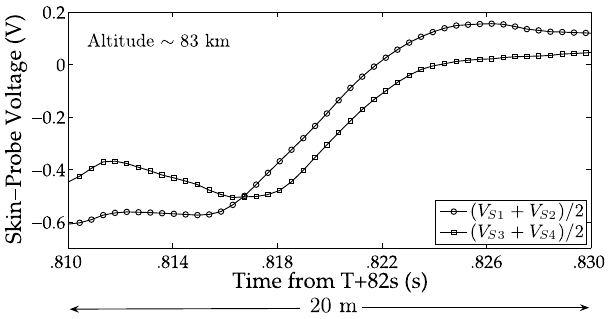
Fig. 5. A high time-resolution view of the onset of the NLC layer in Fig. 4b. The transition takes less than 10ms, over much of which the potential varies linearly with time/altitude. There is a delay between the forward and aft channels of about 2.5ms, which is roughly the time it takes for the aft probes to “catch up” to where the forward probes were (at the rocket velocity of about